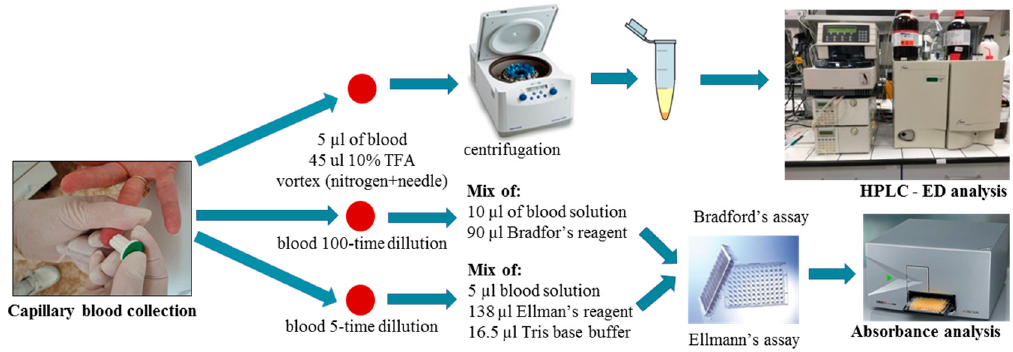
Figure 2. Scheme of glutathione (GSH) and oxidized, dimeric glutathione (GSSH) blood analysis procedure.